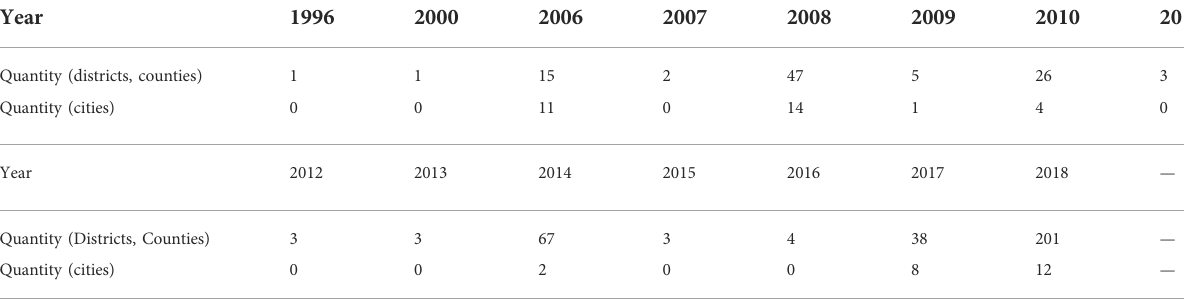
TABLE 1 Establishment of grassroots environmental protection